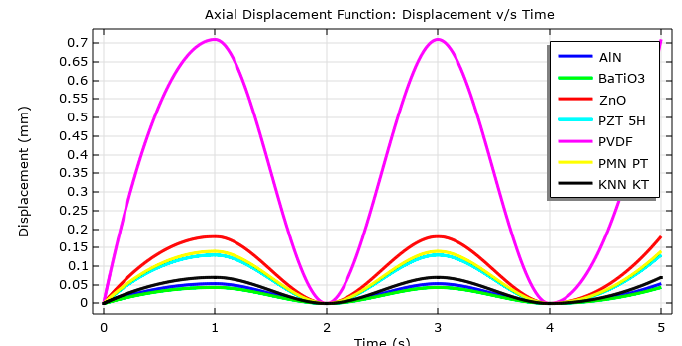
Figure A1. The axial-loading: displacement functions.